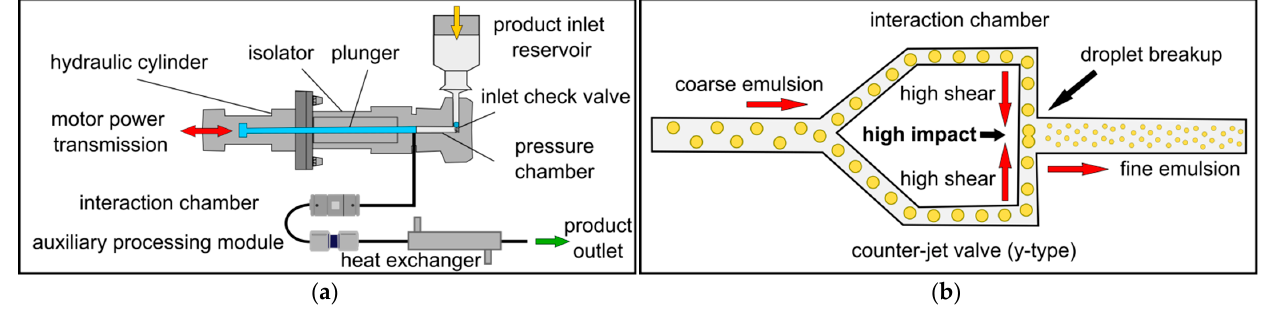
Figure 1. High-pressure homogenizers for the preparation of nanoemulsion products. ( a ) Setup of a jet-valve high-pressure homogenizer consisting of an intensifier pump, interaction chamber, auxiliary processing module and heat exchanger. ( b ) Interaction Y-chamber microchannel, the preferred type for emulsion droplet breakup.